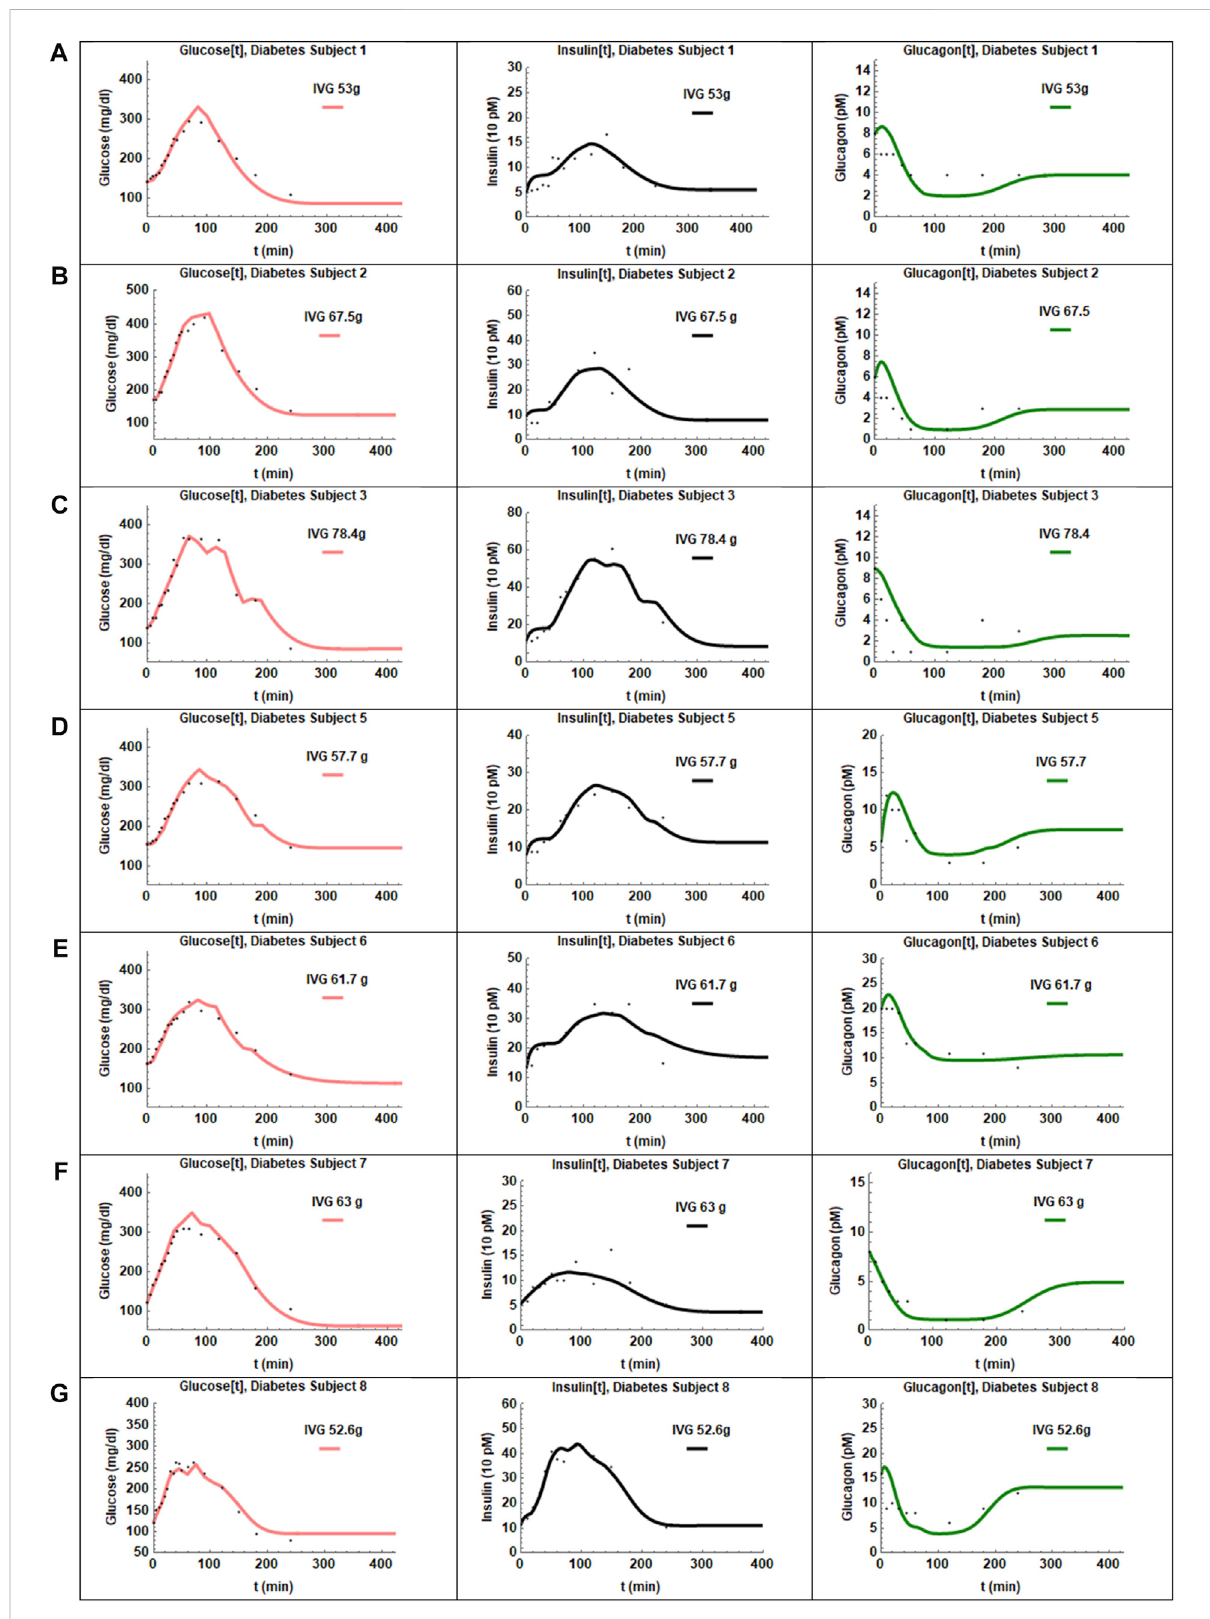
FIGURE 4 The fi ts obtained for the seven patients with T2D are presented in panels (A – G) . The adjusted R 2 values were > 0.98 for all subjects. The glucose and insulin pro fi les were fi t best by the model. Glucagon recovery is slow as seen in panels (A – G) and again described reasonably well by the hysteresis